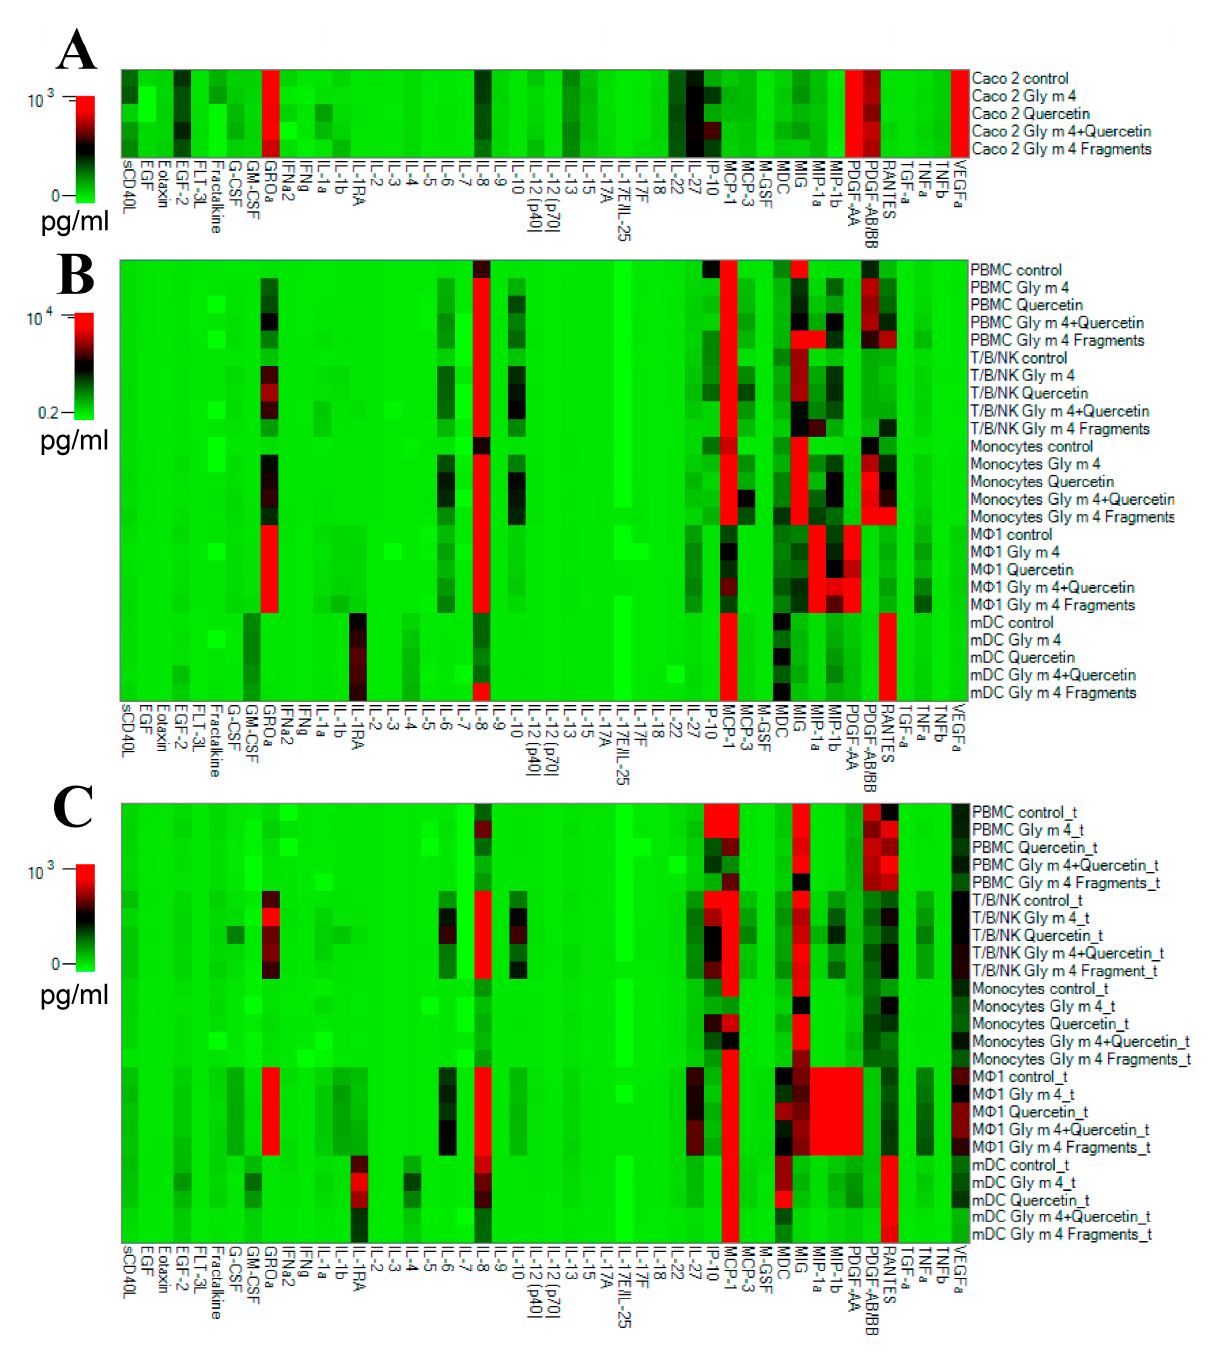
Figure 7. Heat map represented profiles of cytokines/chemokines/growth factors production by ( A ) Caco-2 cell line and ( B ) PBMC, T/B/NK, Monocytes, THP-1-derived M Φ 1, and mDCs in response to the direct stimulation, or ( C ) to the transepithelial stimulation by incubation of the same cultures in basolateral chambers of 24-well Millicel inserts after the compounds passed across the Caco-2 epithelial barriers from an apical side.